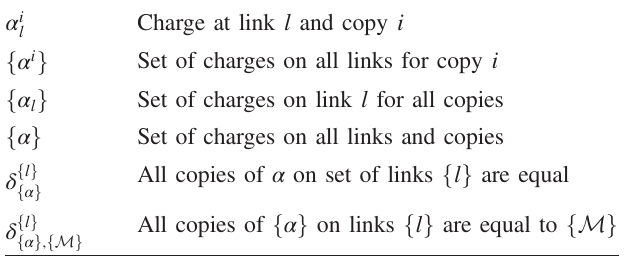
TABLE I. Summary of the meaning of various notations used in this appendix. α i Charge at link l and copy l